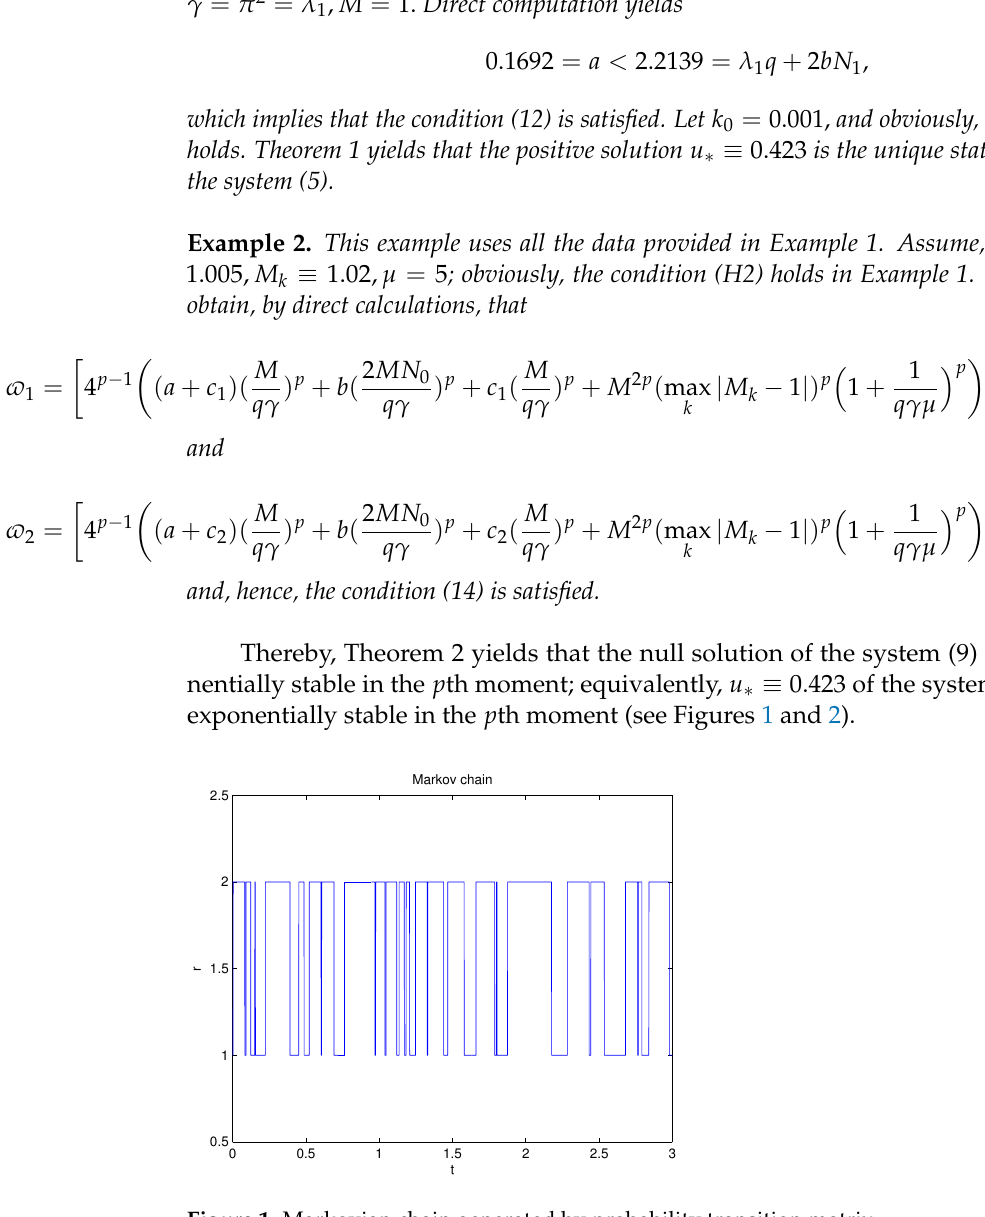
Figure 1. Markovian chain generated by probability transition